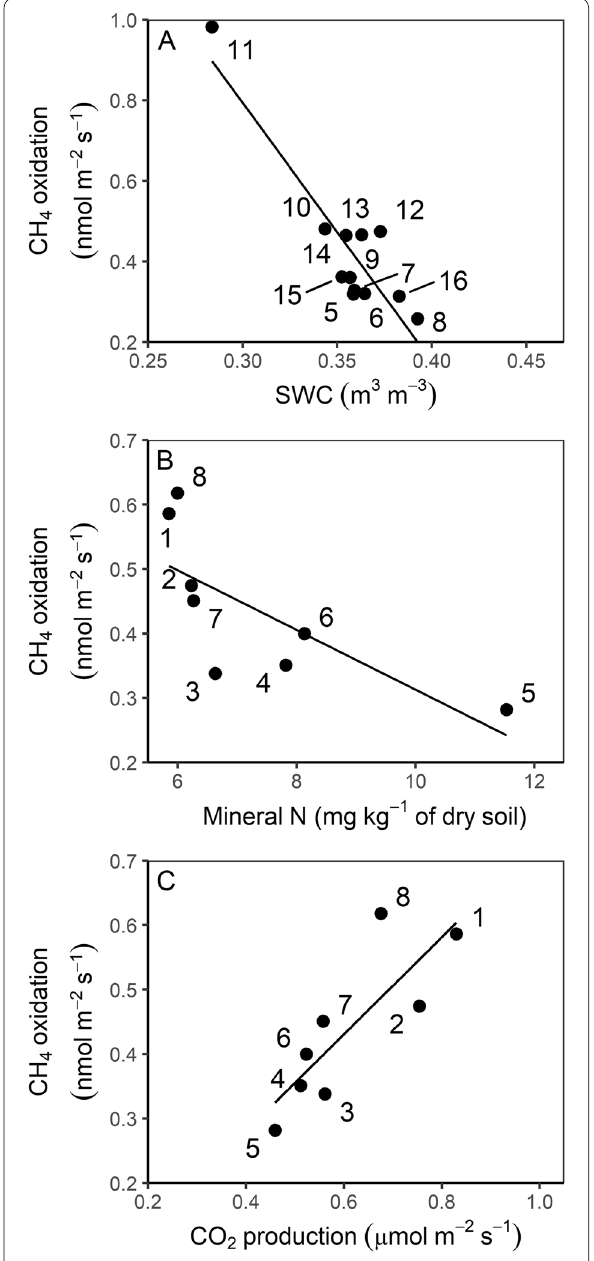
Fig. 3 Relationships between the mean stand values ( n potential CH 4 oxidation in the top soil layer (intact soil cores) and A soil water content (SWC) in spring 2019 ( R 2 mineral nitrogen concentrations in summer 2019 ( R 2 0.036), and C CO 2 production in summer 2019 ( R 2 Solid lines represent the linear regressions. Numbers are the ID of the stands, from youngest to oldest